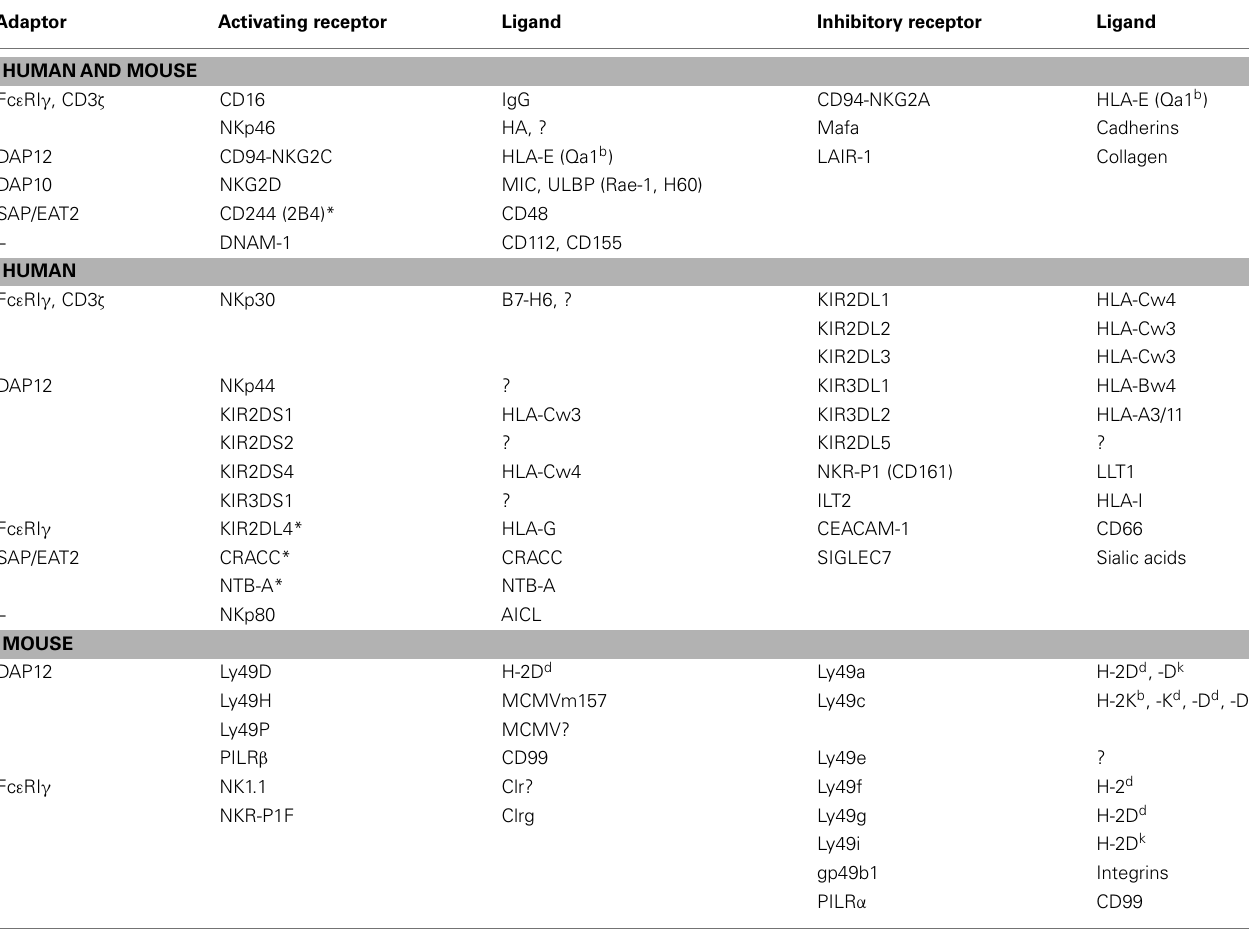
Table 1 | Natural killer cell activating and inhibitory receptors in mice and humans and their ligands. Adaptor